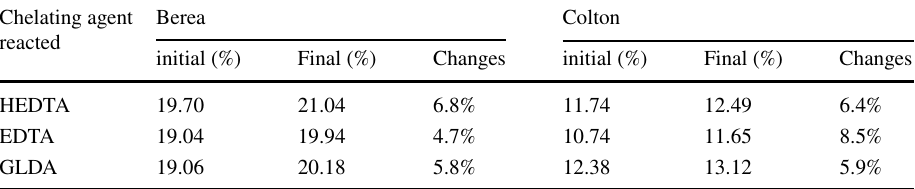
Table 3 Initial and final porosity of berea and colton